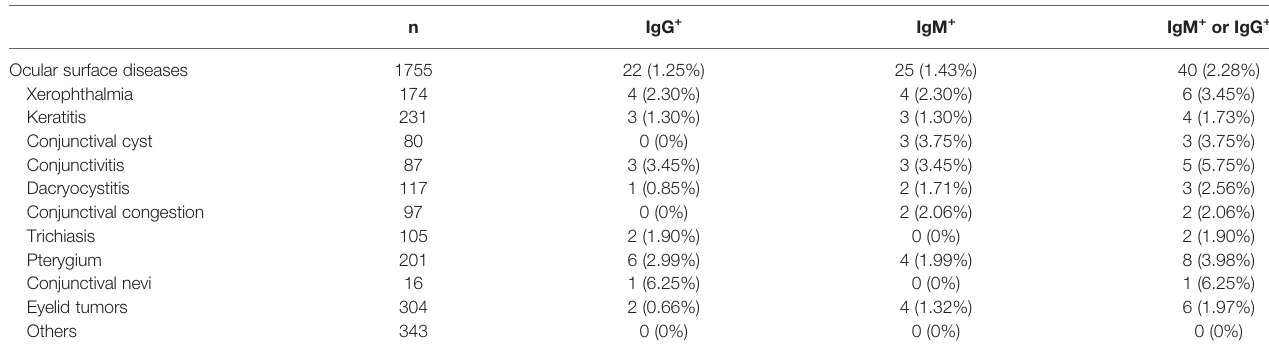
TABLE 3 | SARS-CoV-2 seroprevalence among different type of ocular surface diseases. n IgG + IgM + IgM + or IgG